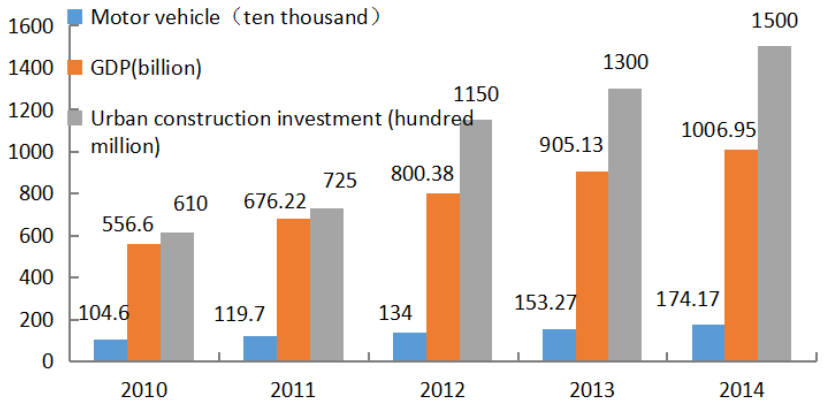
Figure 4. Trends of community-level factors.